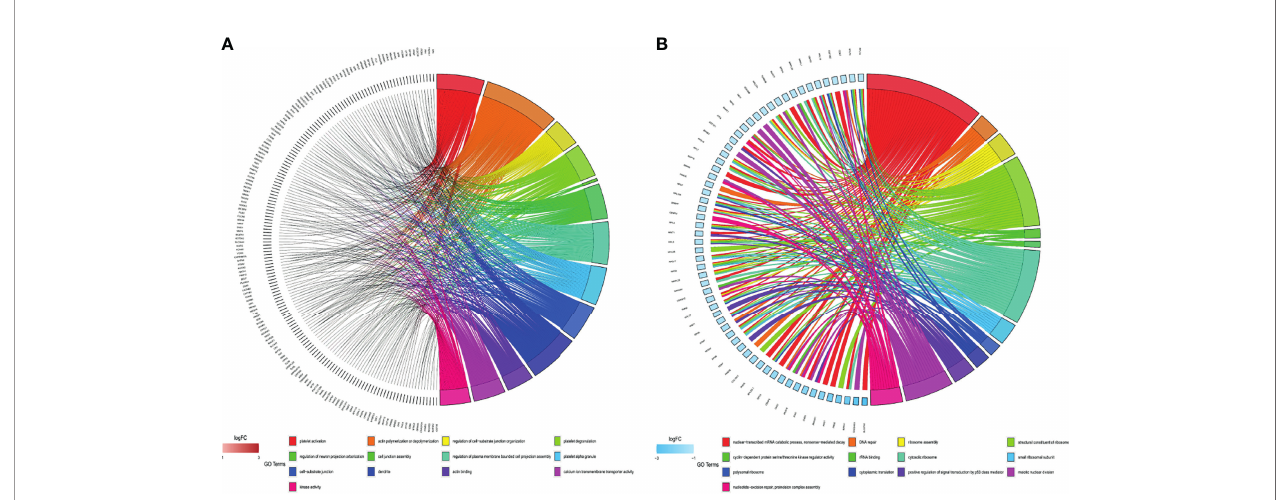
FIGURE 4 | Gene Ontology (GO) analyses of all differentially expressed genes (DEGs). (A) GO enrichment of the upregulated DEGs. (B) GO enrichment of the downregulated DEGs.